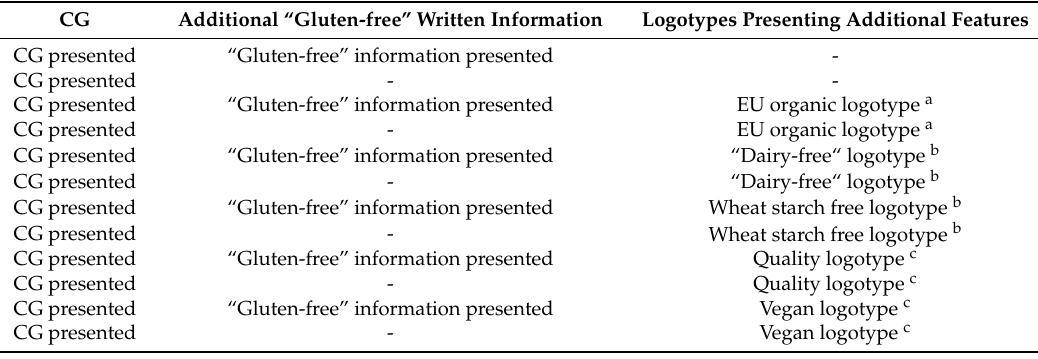
Table 3. The scheme of the choice experiment (CE) with the detailed characteristics of products presented in a random order during the